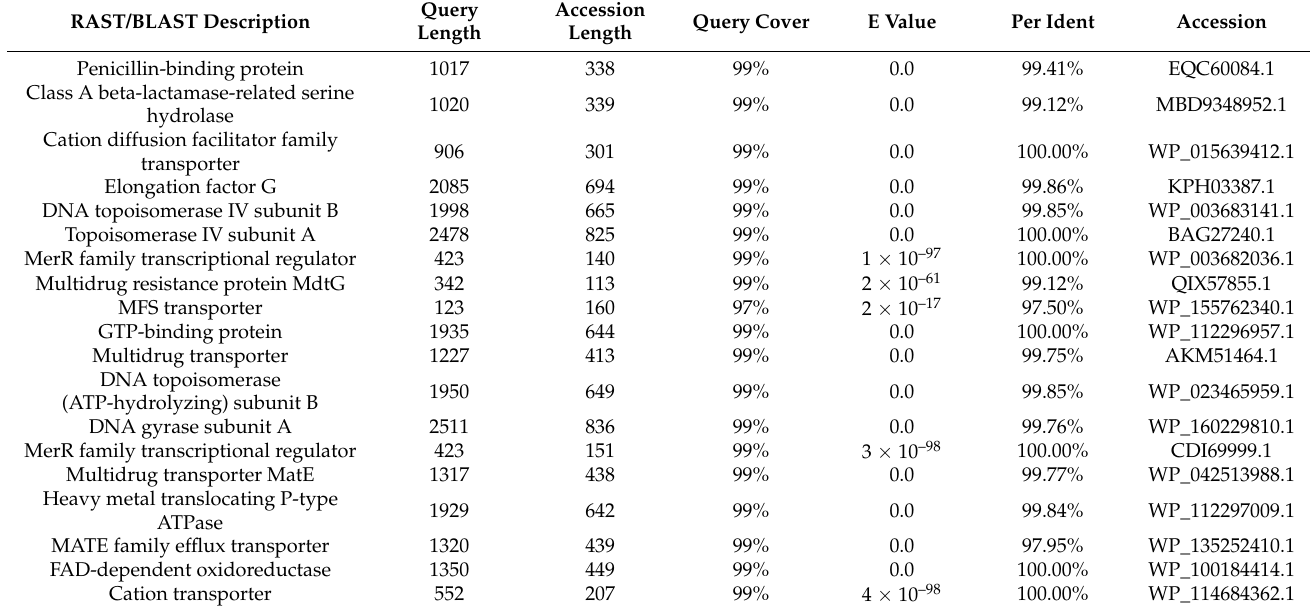
Table 5. Putative genes involved in resistance to antibiotics and toxic